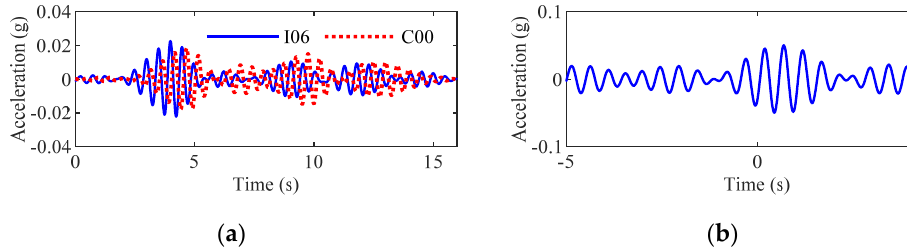
Figure 13. ( a ) Filtered accelerations for accelerations at stations I06 and C00 when ω 0 = 2 Hz; ( b ) cross-correlation of the filtered accelerations.